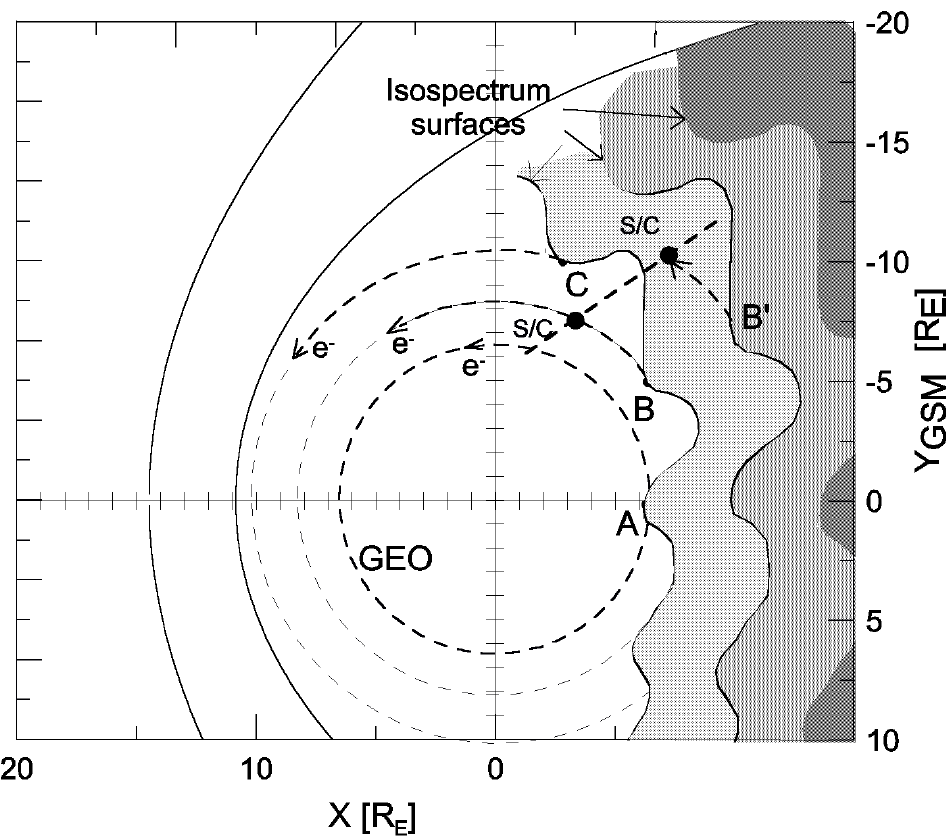
Fig. 6. Schematic showing three successive and meandering isospectrum surfaces. The darkest area corresponds to the densest populated region. The injected electrons from the earthward protrusions A, B, C and B 0 produce dispersive fluxes at increasing radial distances. The bow shock and magnetopause surfaces (solid lines), the GEO (thick- dashed line) orbit and the satellite (S/C) trajectory are